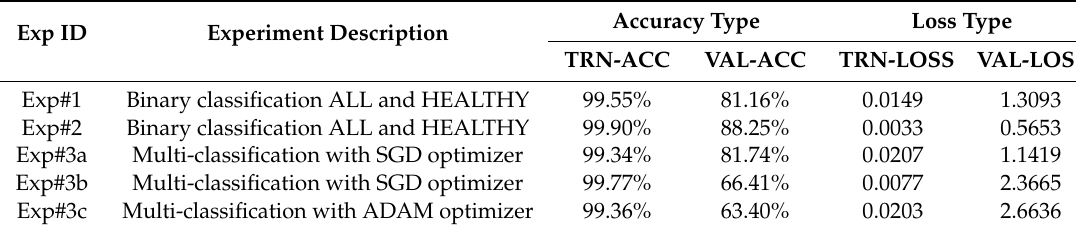
Table 2. Accuracy and loss results for each